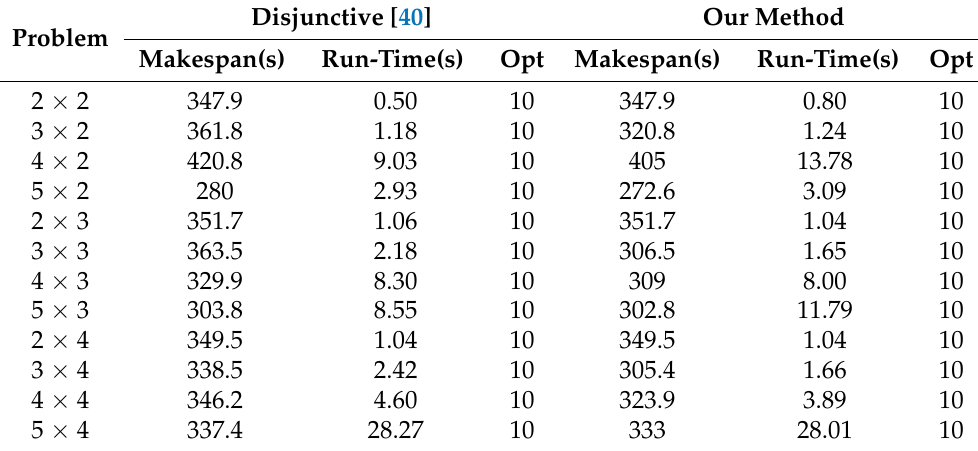
Table 2. The comparison result of a conventional disjunctive algorithm and our